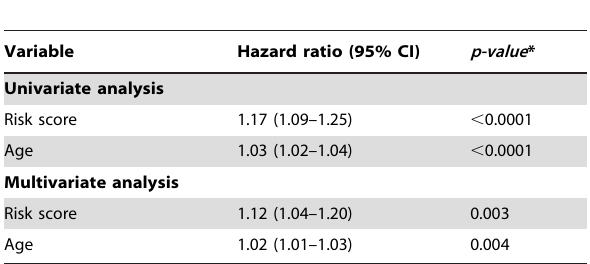
Table 4. Cox regression analysis of risk score and age in the entire patient set (n=222).